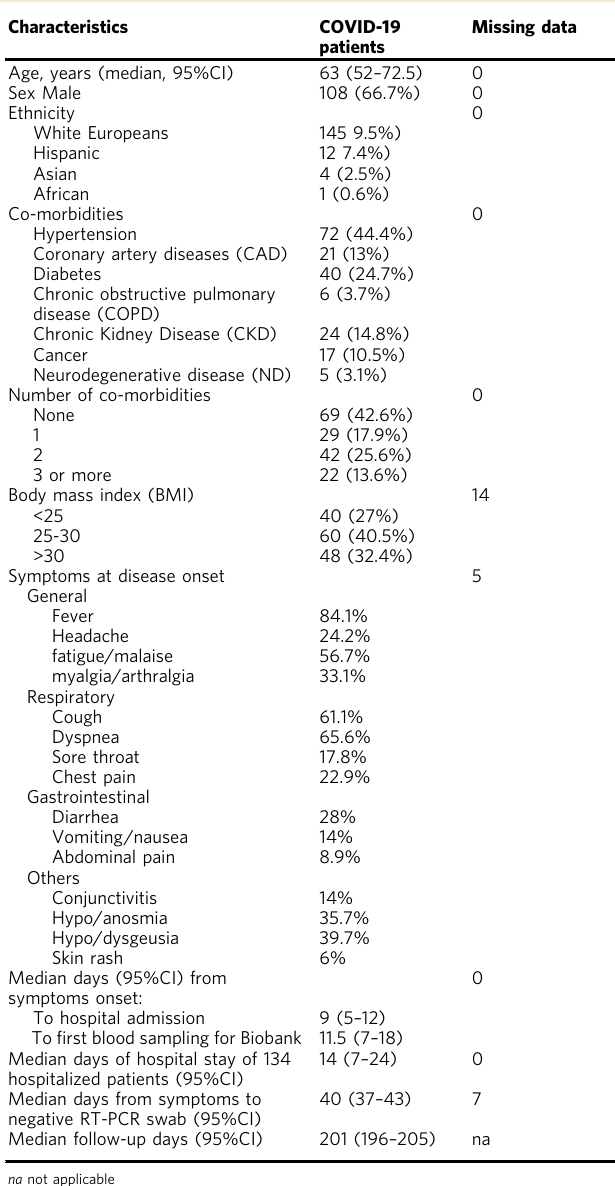
Table 2 Characteristics of the COVID-19 study population (No. =